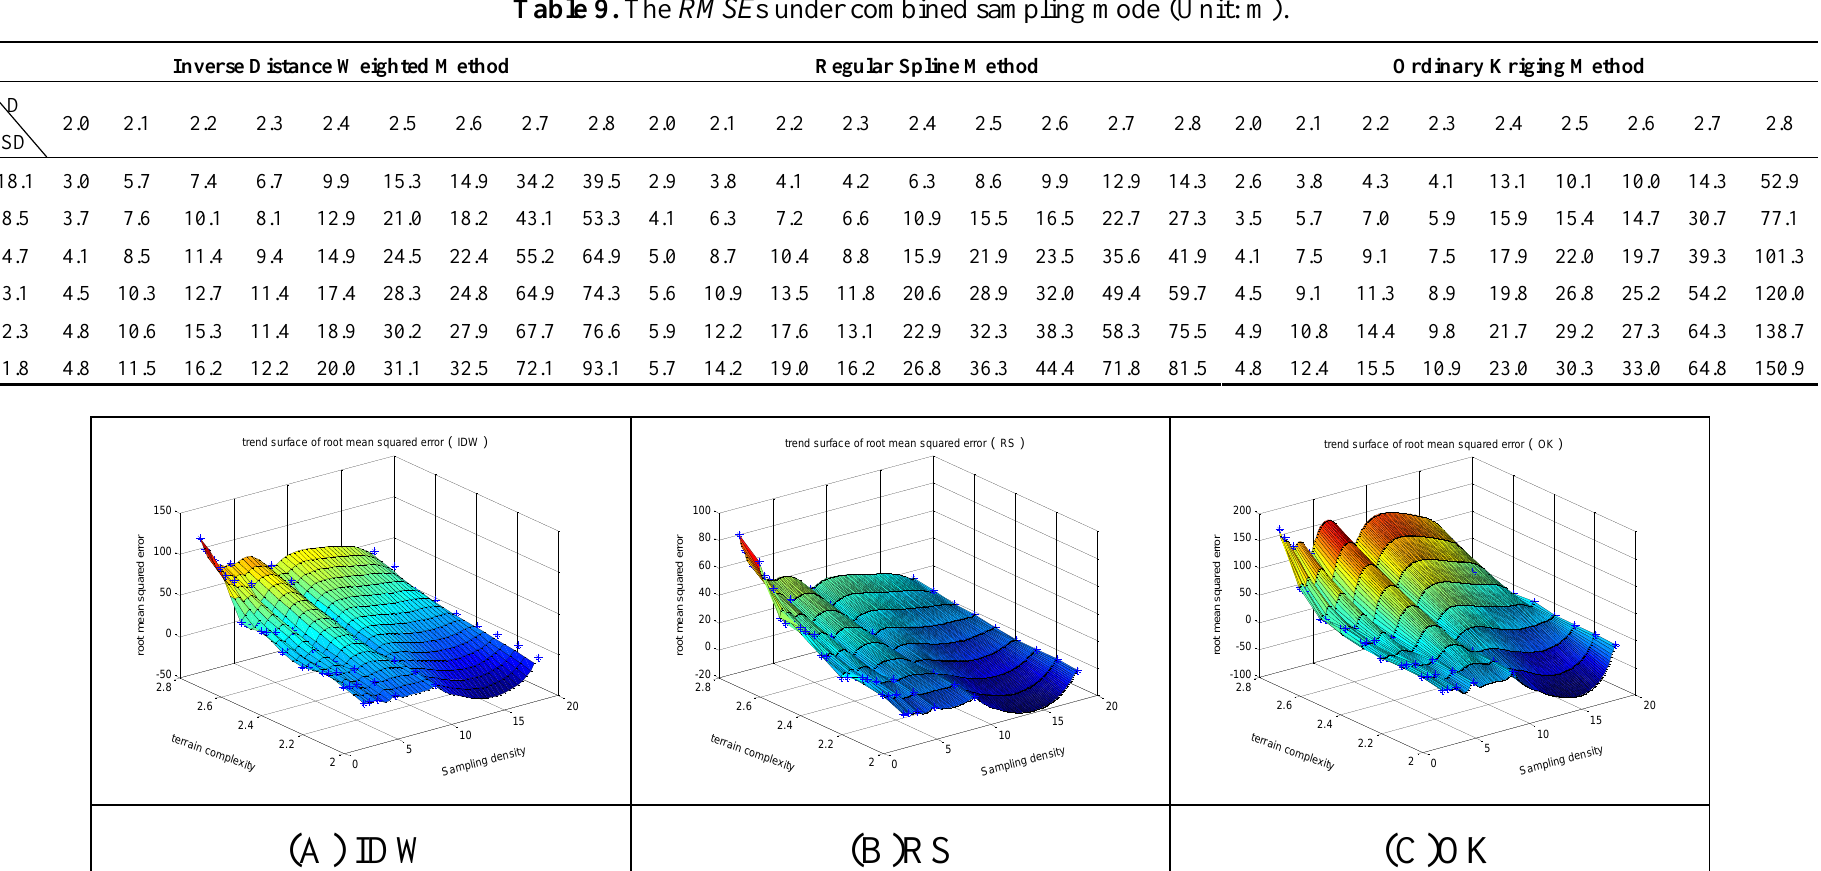
Figure 9. The RMSE s of the 3 methods in regular-grid sampling. ( A ) The trend surface of RMSE s for IDW; ( B ) The trend surface of RMSE s for RS; ( C ) The trend surface of RMSE s for